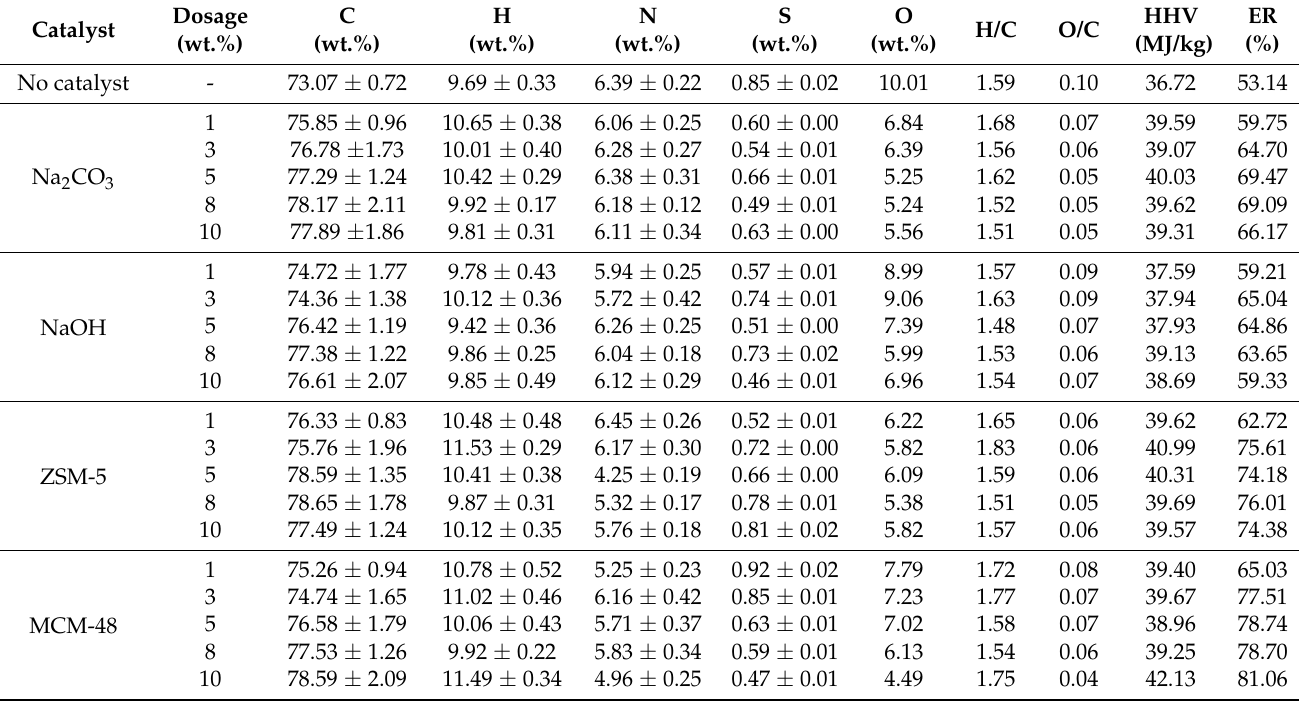
Table 2. The influence of the catalyst dosage on the elemental composition, HHV and ER of bio-oil.